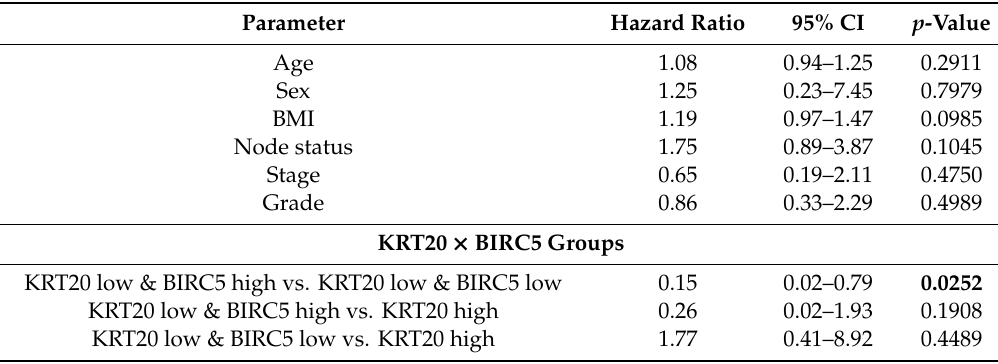
Table 4. Cox regression analysis for progression-free survival (PFS) by BIRC5 × KRT20 mRNA expression and clinicopathological features in the PCR cohort of bladder cancer patients treated with adjuvant chemotherapy. Statistically significant values are highlighted in